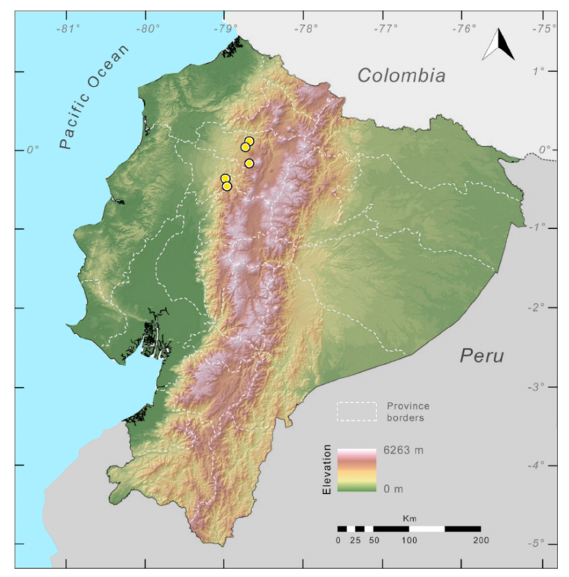
Figure 162. Distribution of Nymphargus lasgralarias in Ecuador (yellow dots).